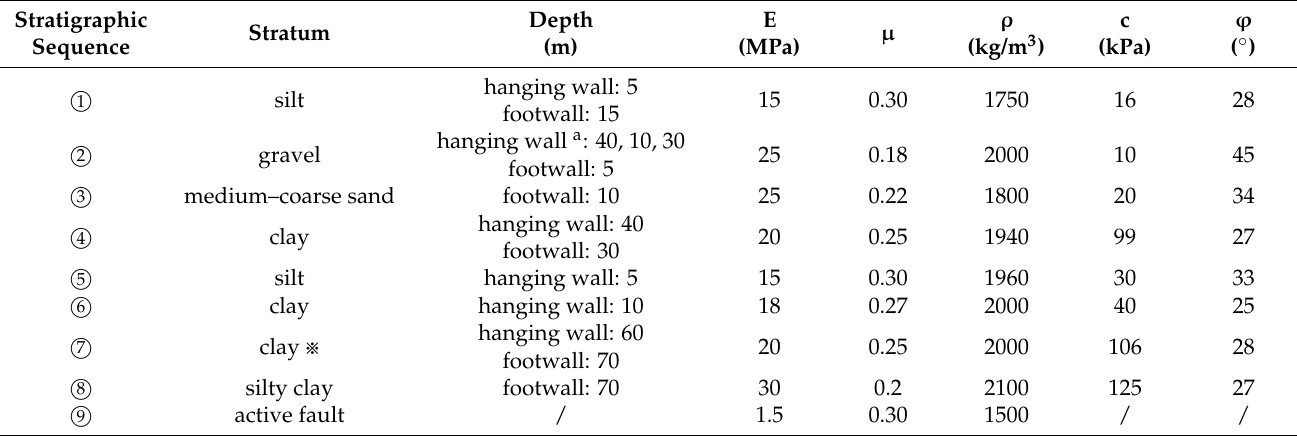
Table 5. The parameters of each soil layer.